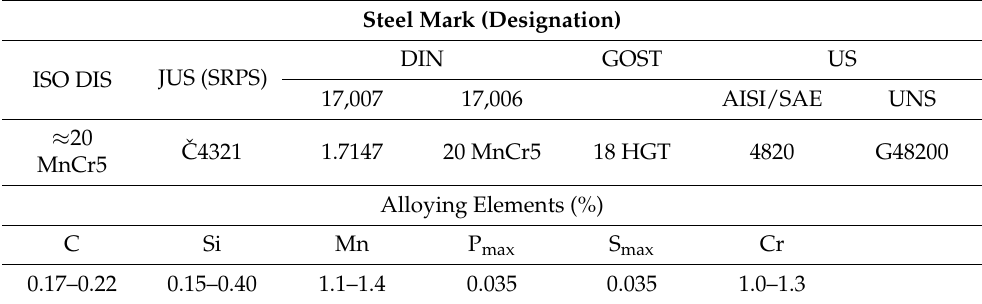
Table 1. Chemical composition of the base